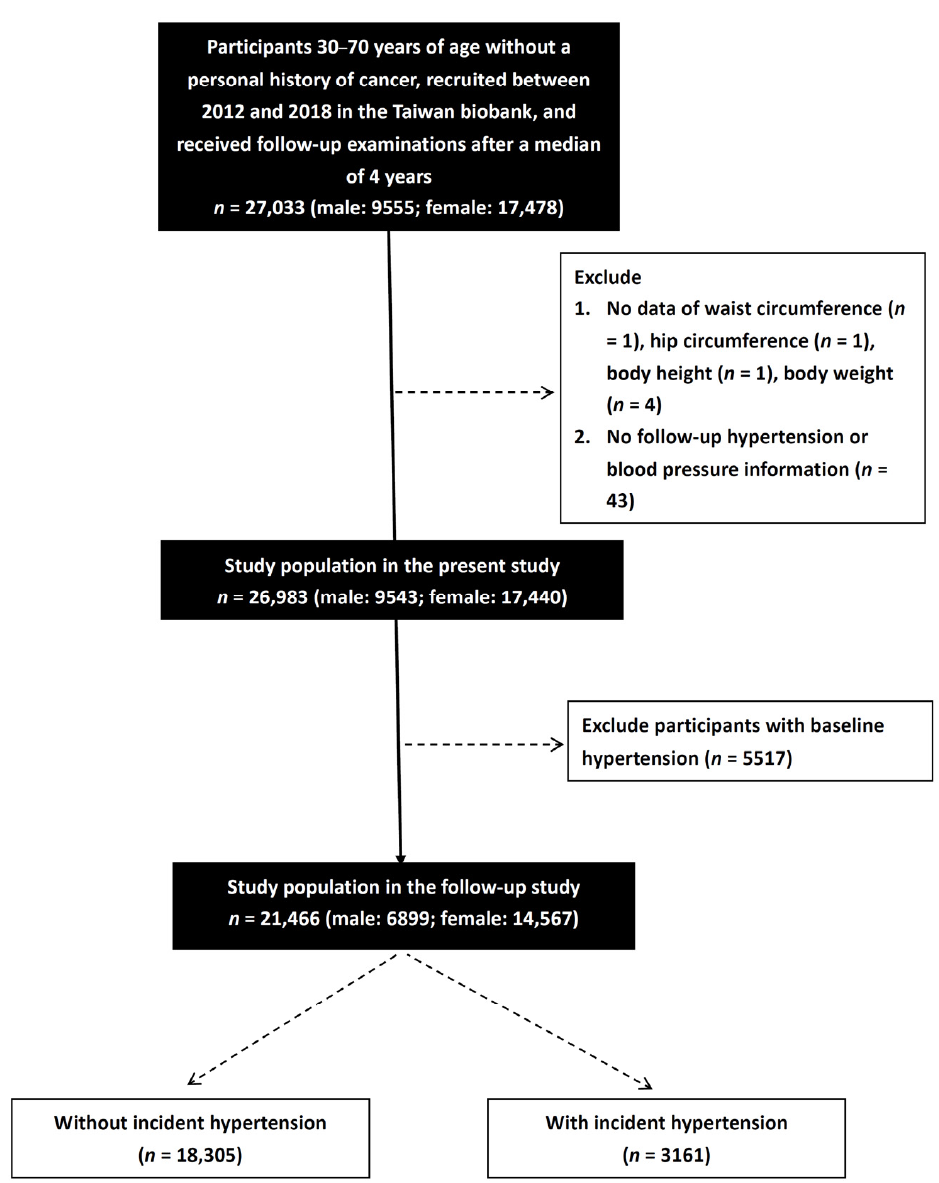
Figure 1. Flowchart of study population.